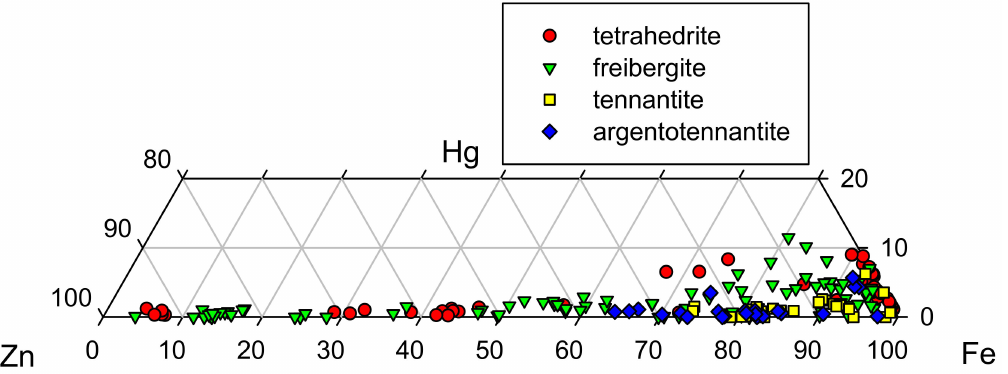
Figure 15. Part of the ternary Fe–Hg–Zn ( apfu ) plot for members of the tetrahedrite group from the Kremnica